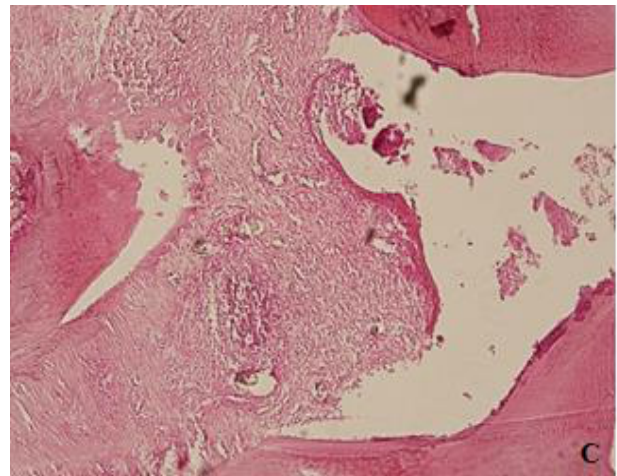
Fig. 4. Mild inflammation, bone resorption & loss of collagen fiber orientation in the furcation area (A), Moderate inflammation, bone resorption & loss of orientation in the distal area (B), Severe inflammation with follicle formation, bone resorption & loss of orientation in the distal area (C) of the diseased periodontium (H&E staining, 200X).